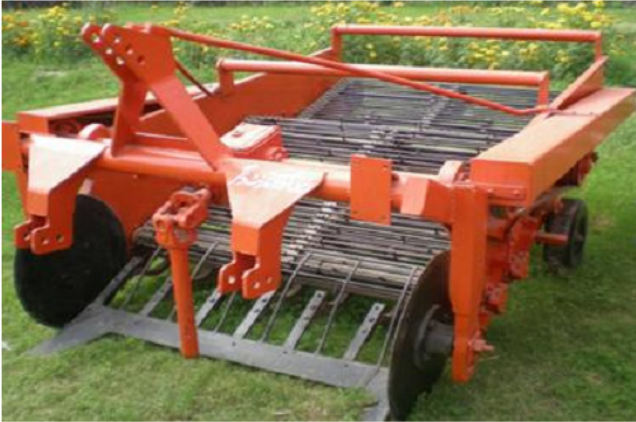
Figure 2. General view of the harvesting root crops machine.